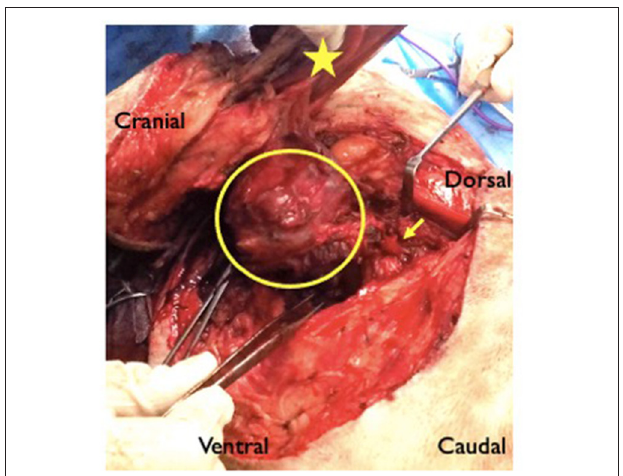
FIGURE 3 | Intraoperative image from case 2 showing a large ovoid axillary mass (circled) with extension (arrow) toward the C7–T1 intervertebral foramen. The star shows the medial aspect of the scapula. The forceps in the surgeon’s right hand show the region of the osteotomised